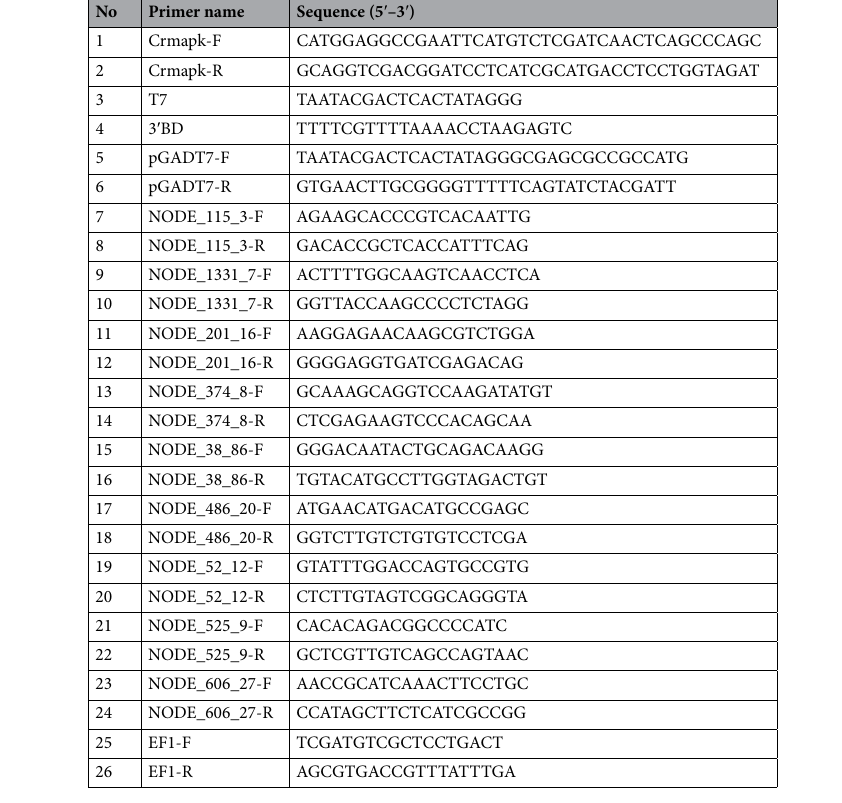
Table 3. Primers used in this